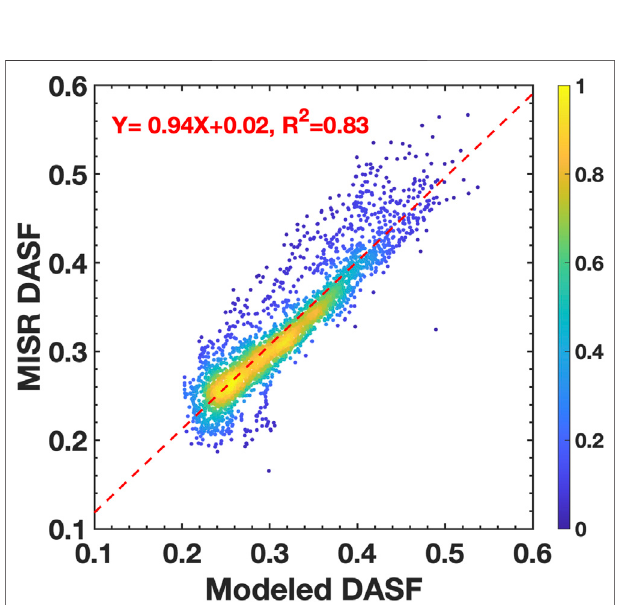
FIGURE 6 | (A) MISR DASF of Amazonian forests in April-2016 (hollow circles) and its approximation by Eq. 4 (dots). The dashed line is a polynomial fi t to the modeled DASF. (B) MISR DASF vs. modeled DASF. NRMSE (cid:2) 4%.